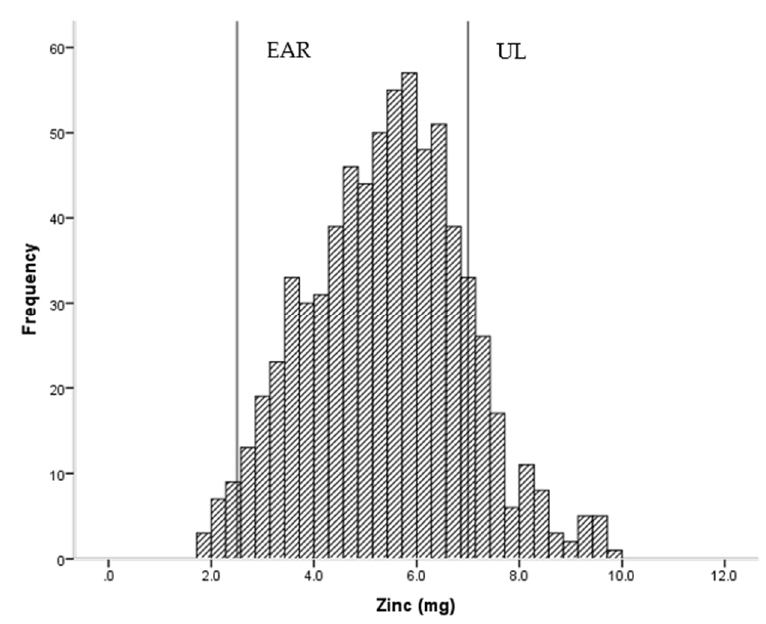
Figure 1. Frequency of intake of iron ( n = 714) showing estimated average requirement (EAR = 4 mg) and upper limit of intake (UL = 20 mg).